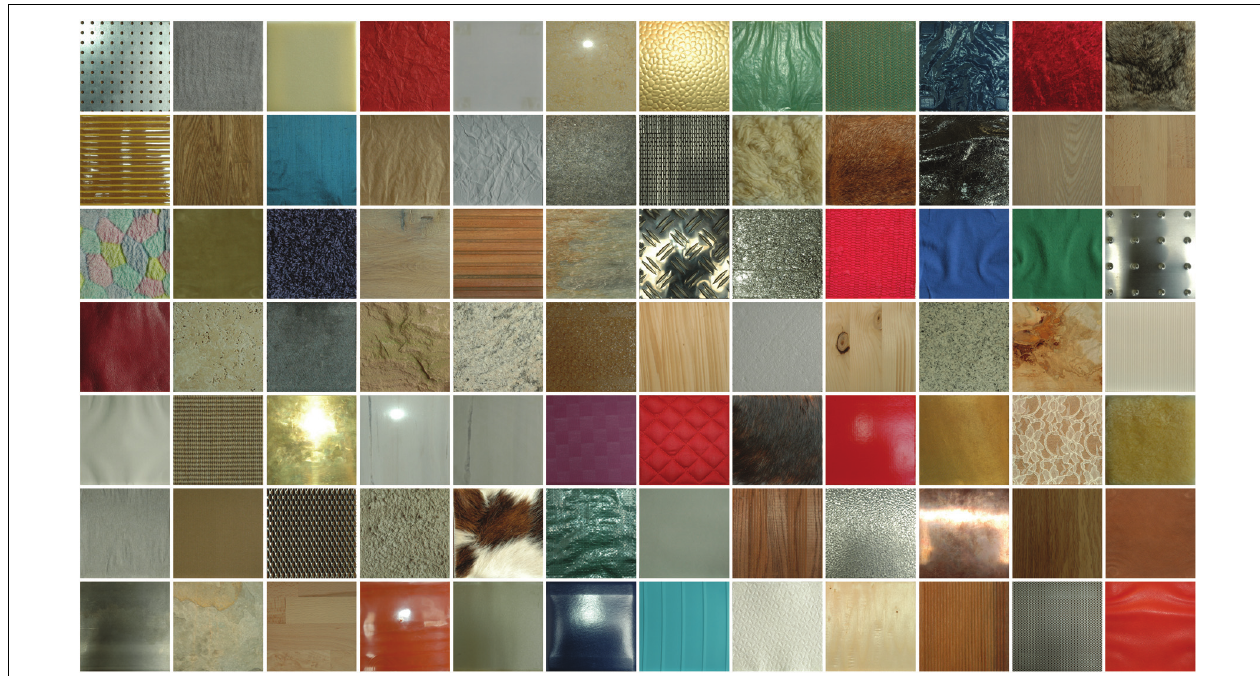
FIGURE 1 | The material photographs used in the fMRI